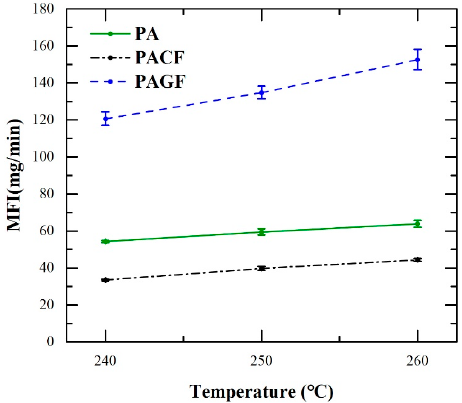
Figure 6. Melt flow index (MFI) of PA, PAGF, and PACF at different temperatures.